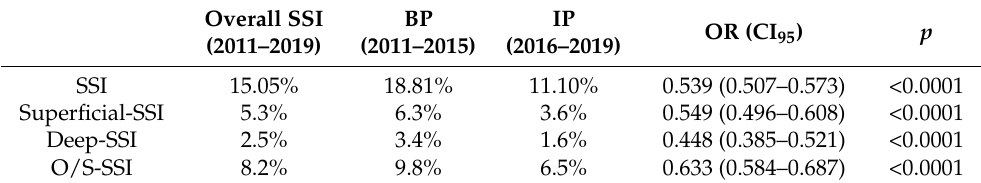
Table 3. Colorectal surgery SSI rates during the study period (2011–2019) and comparison of IP and BP.